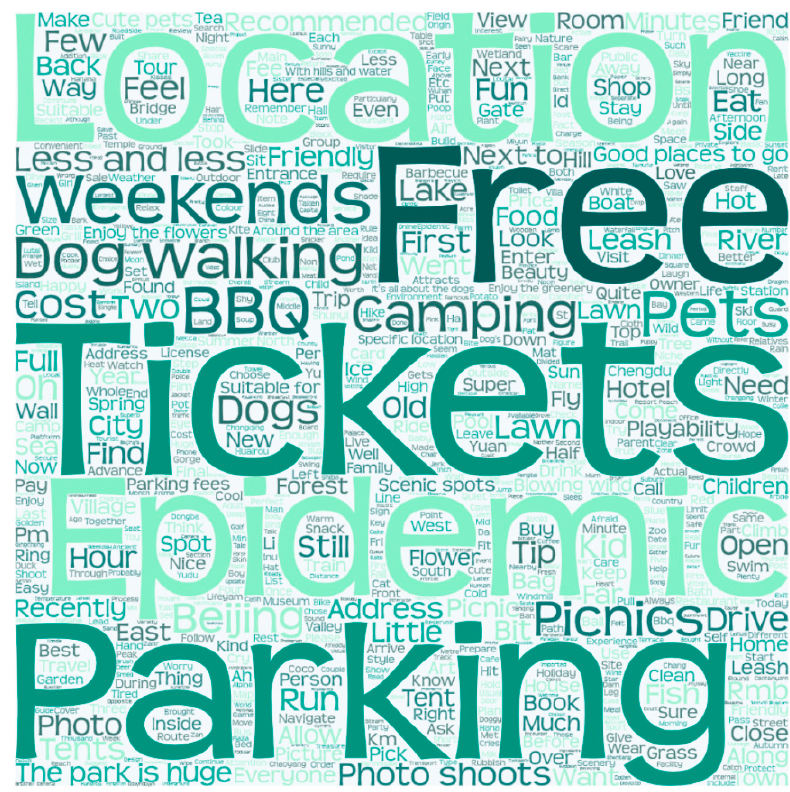
Figure 3. Perceptive word cloud map (during the outbreak).